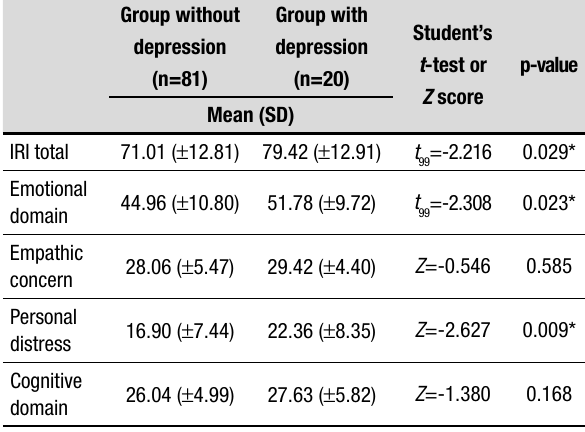
Table 2. Mean and standard deviation of the groups with and without depression in the Interpersonal Reactivity Index task and its respective domains. Group without Group depression (n=81)